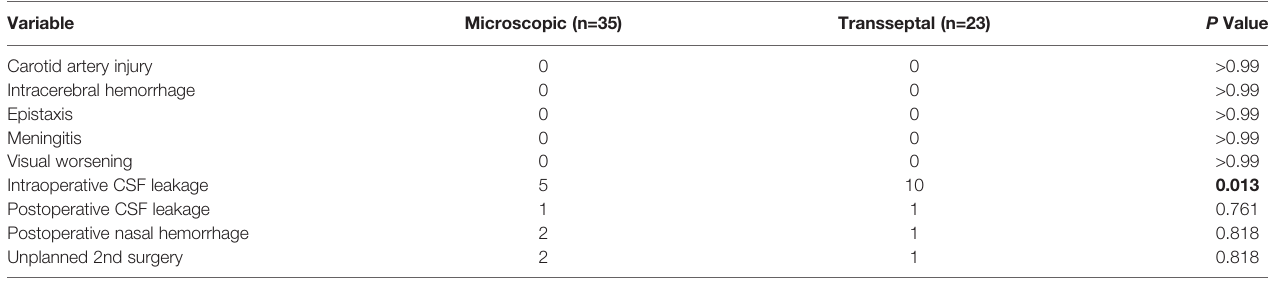
Bold values, statistically signi fi